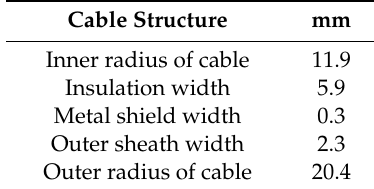
Table 1. Parameters of cable structure.